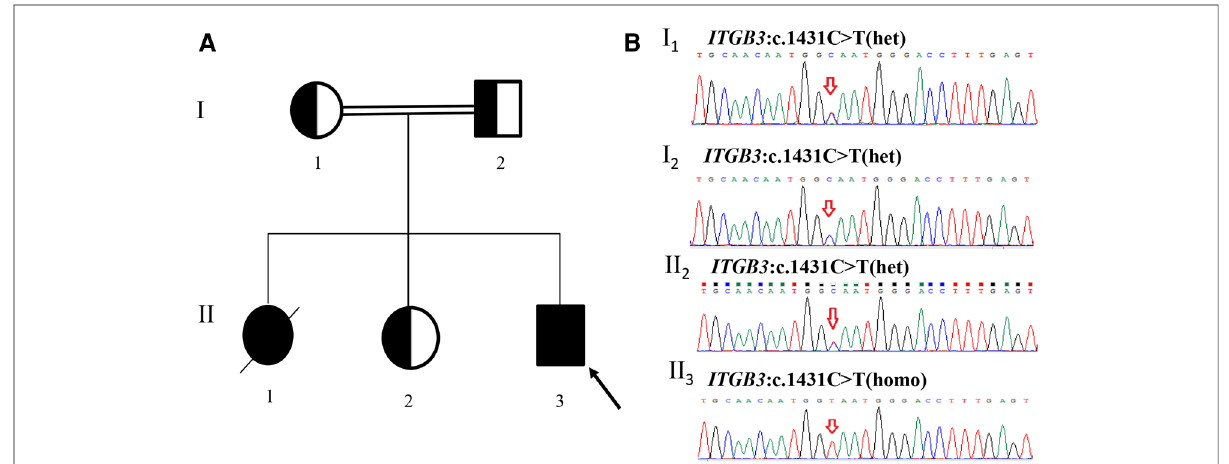
FIGURE 1 Pedigree of the family and sanger sequencing validation. ( A ) II 3 (proband) had a homozygous mutation (c.1431C>T) in exon 10 of ITGB3 gene. I